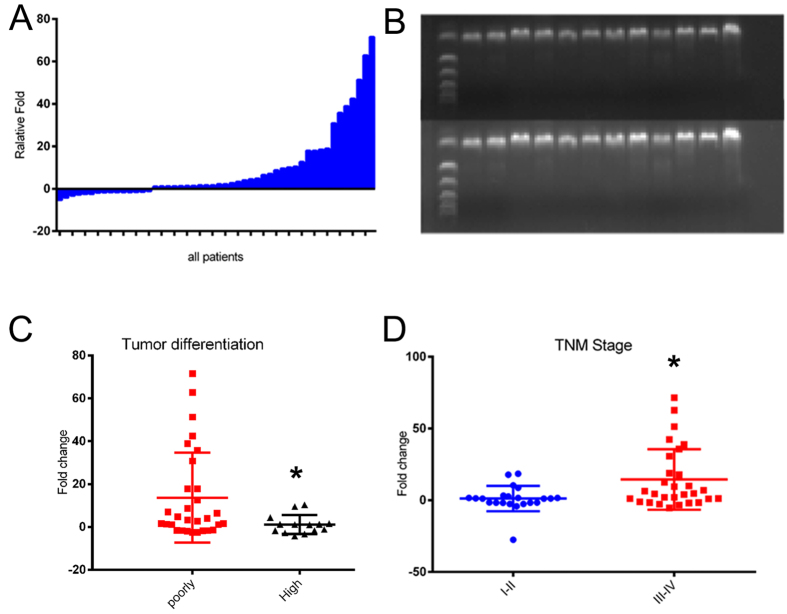
Analysis of hsa_circ_0067934 expression in ESCC tissues and clinical parameters.(A) hsa_circ_0067934 was detected in 51 pairs of ESCC tissues by qRT-PCR. The levels of hsa_circ_0067934 in ESCC tissues are significantly higher than those in non-tumor tissues (P = 0.011). Nucleic acid electrophoresis directly shows that hsa_circ_0067934 expression was upregulation in ESCC tumor tissues (The image below means the ESCC tumor tissue). Hsa_circ_0067934 was upregulated inpatients with poor differentiation and TNM III-IV stage. *P < 0.05. Error bars indicate S.E.M.